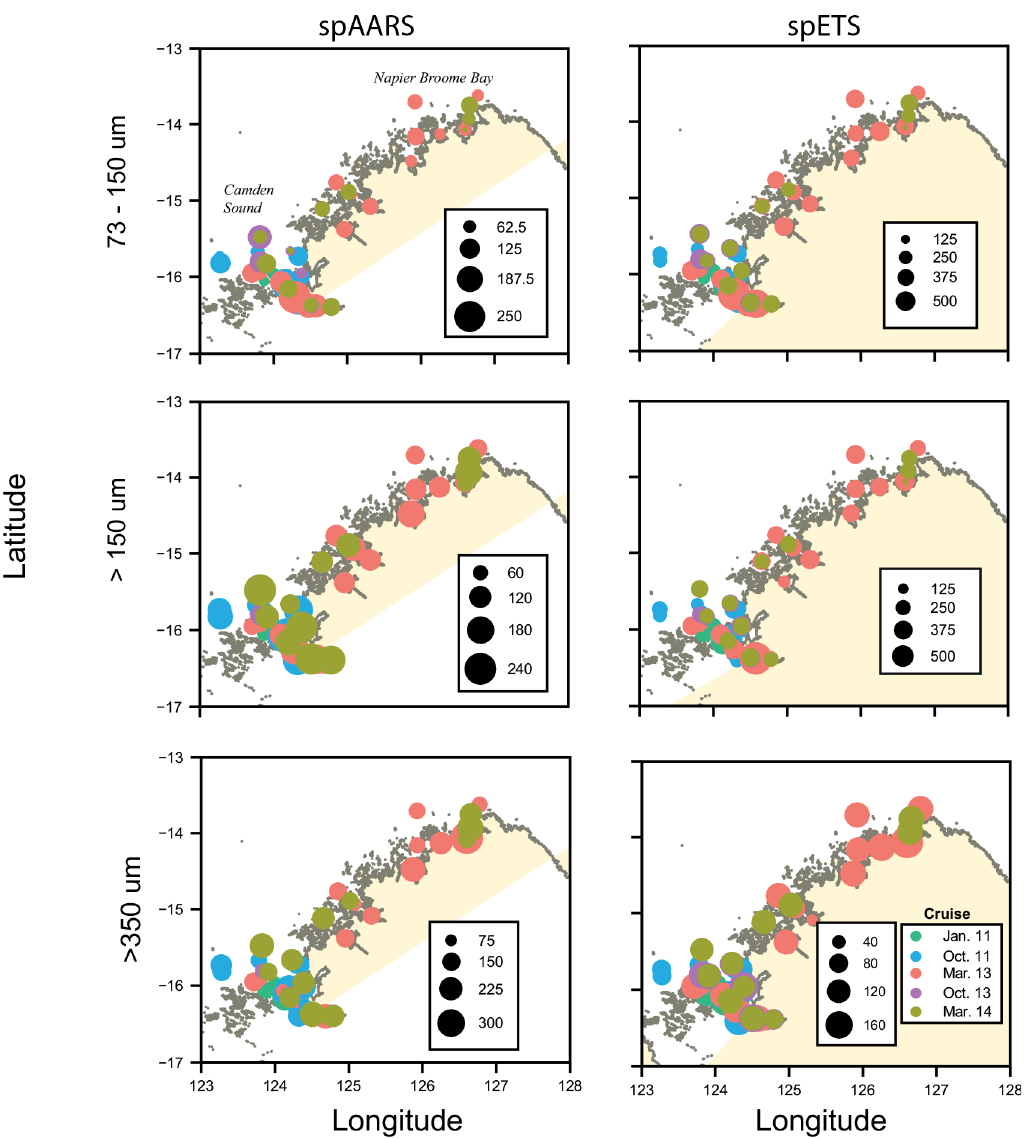
Fig 3. Enzyme activities (spAARS: nmol PPi hr -1 mg protein -1 ; spETS: μ L O 2 hr -1 mg protein -1 ) in the Kimberley region (see Table 1).